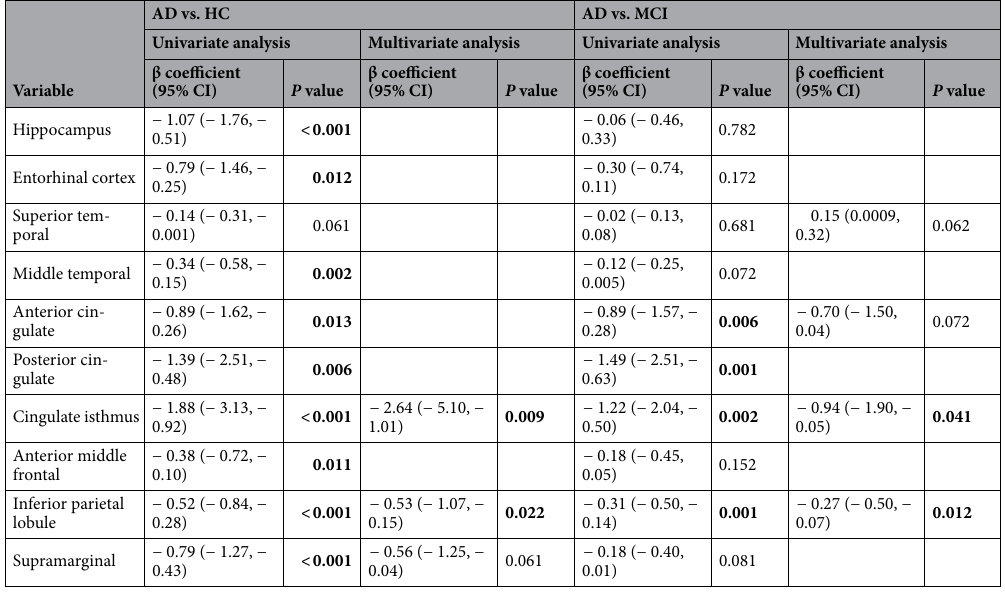
Table 2. Univariate and multivariate logistic regression analysis of automated volumes on MRI for discriminating AD from HC and MCI.